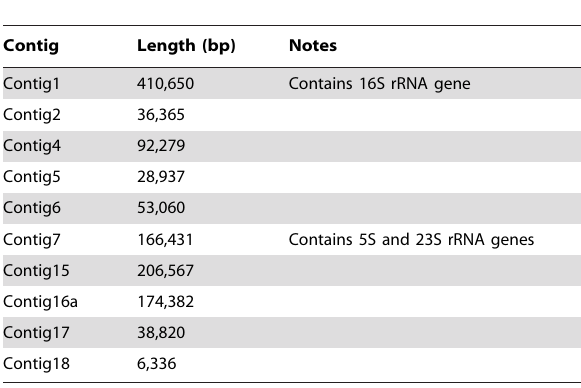
Table 6. Contig lengths in the assembly of Ca. X. pacificiensis.